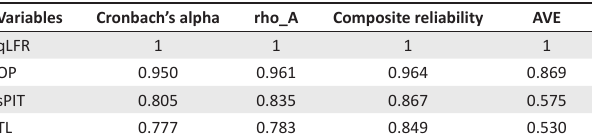
TABLE 1: Quality criteria of outer model. Variables